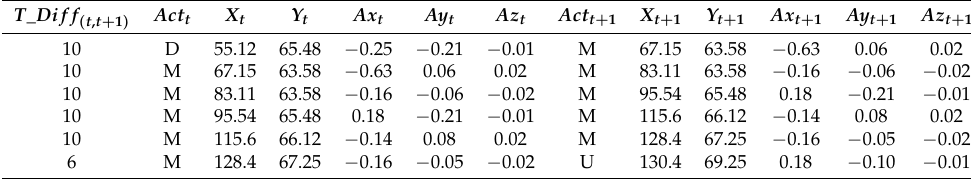
Table 5. Data transformed from the collected raw data.